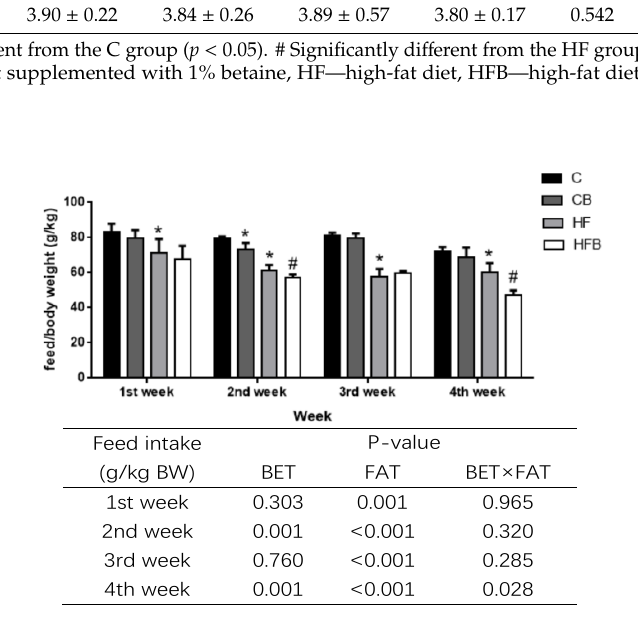
Figure 2. Effects of betaine and high-fat diet on daily feed intake of rats during the trial period ( n = 8). C—basal diet, CB—basal diet supplemented with 1% betaine, HF—high-fat diet, HFB—high-fat diet supplemented with 1% betaine. * Significantly different from the C group ( p < 0.05). # Significantly different from the HF group ( p < 0.05).